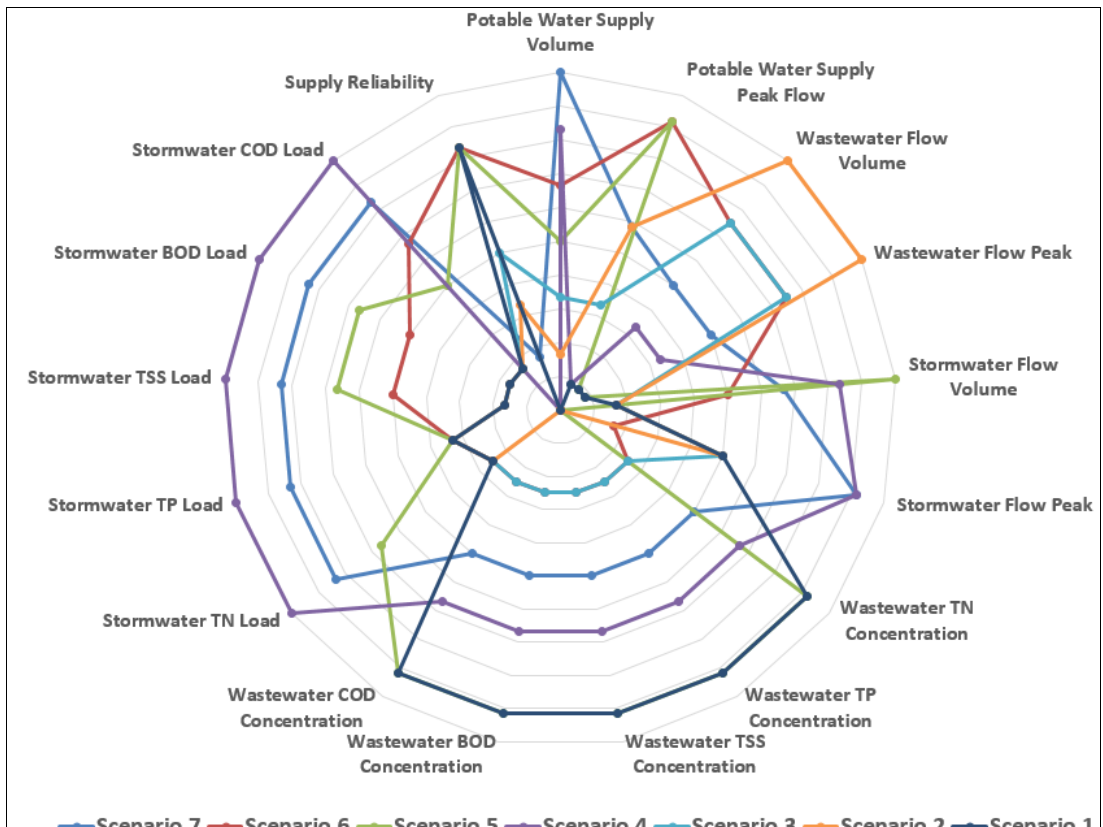
Figure 4. Spider web chart for different hybrid water supply scenarios.